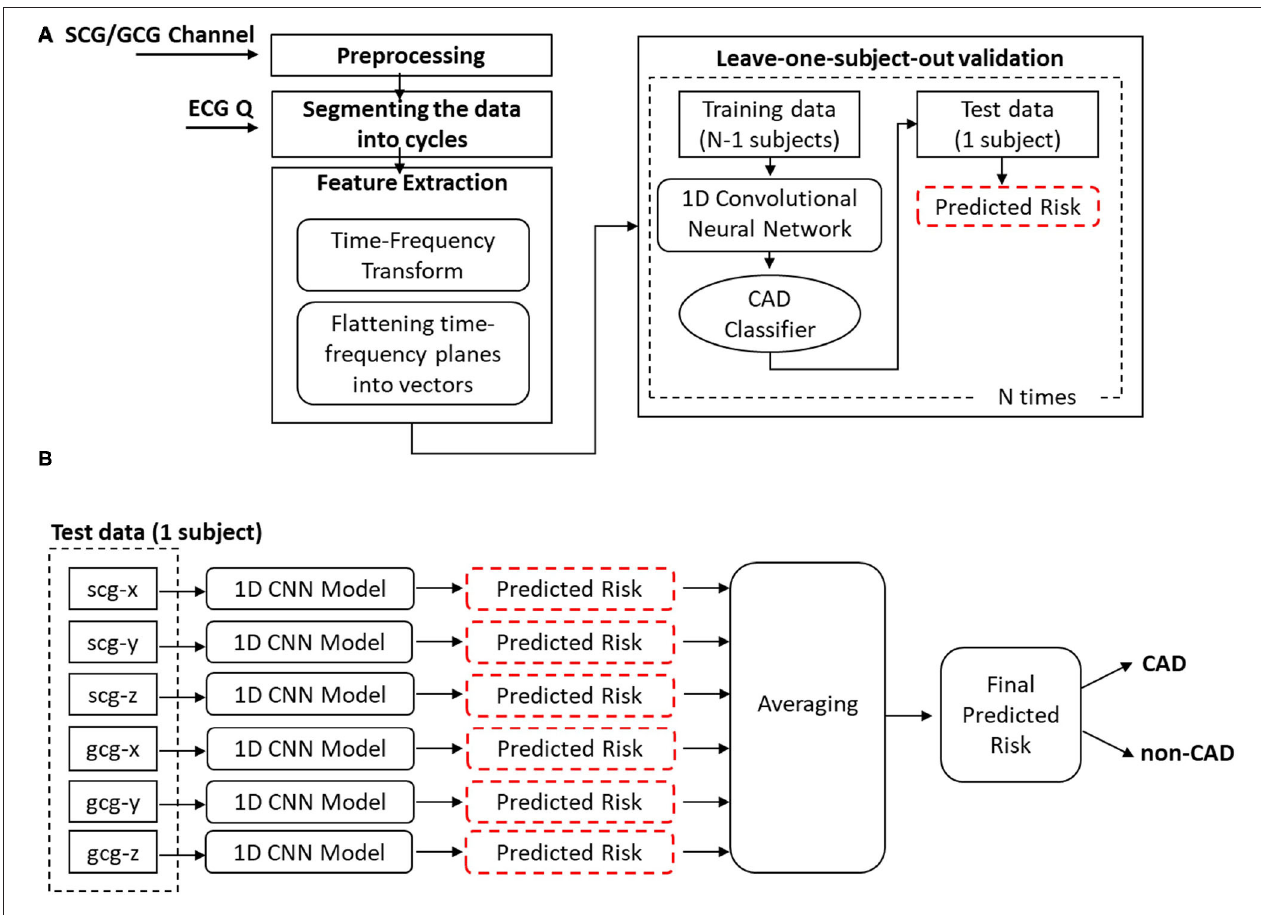
FIGURE 2 | (A) Different steps of methodology (B) Ensemble learning.